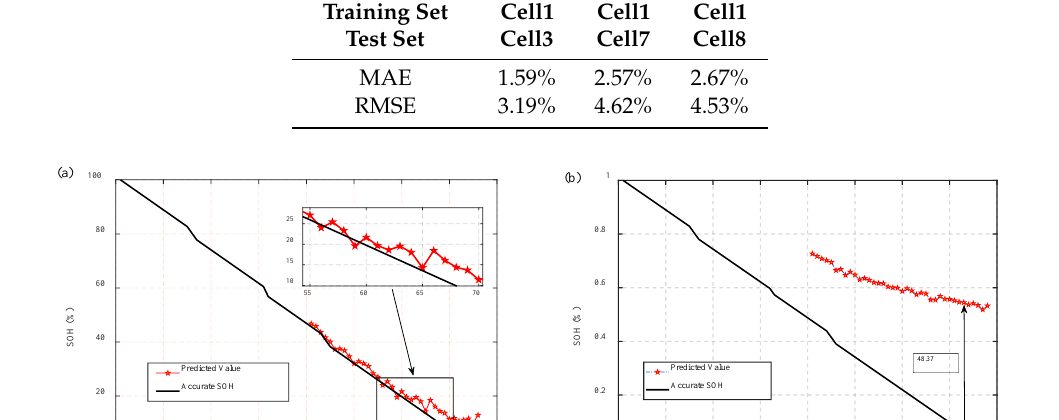
Table 1. Testing the reliability of extreme learning machine (ELM) models using similar data sets. MAE—mean absolute error; RMSE—root mean squared error.